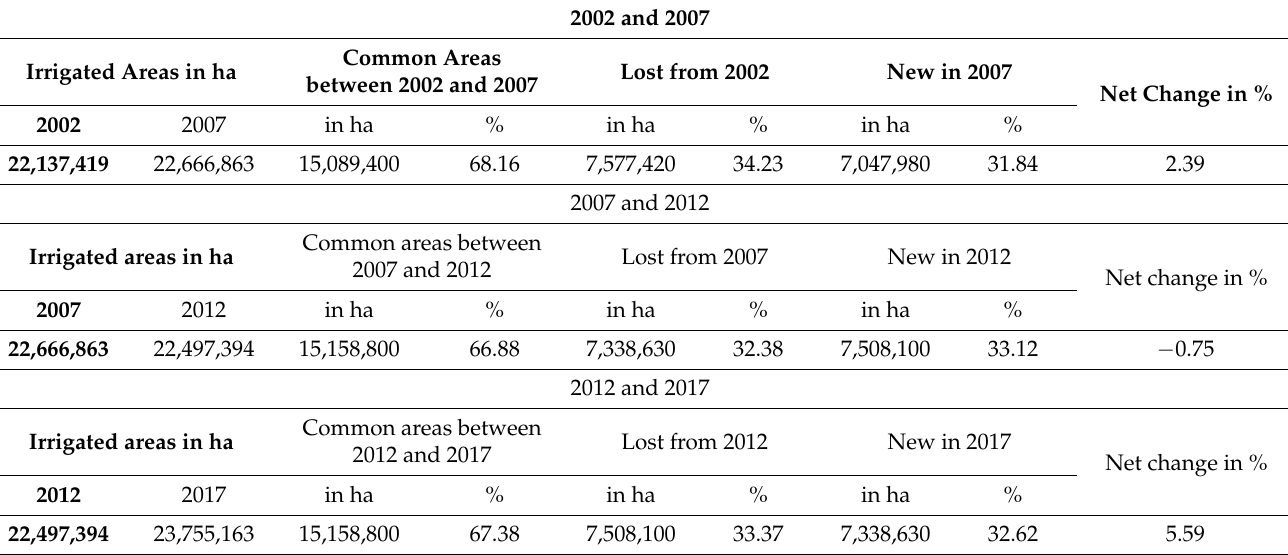
Table 2. Dynamics of the U.S. irrigated land between 2002 and 2017 at 5-year mapping intervals. 2002 and